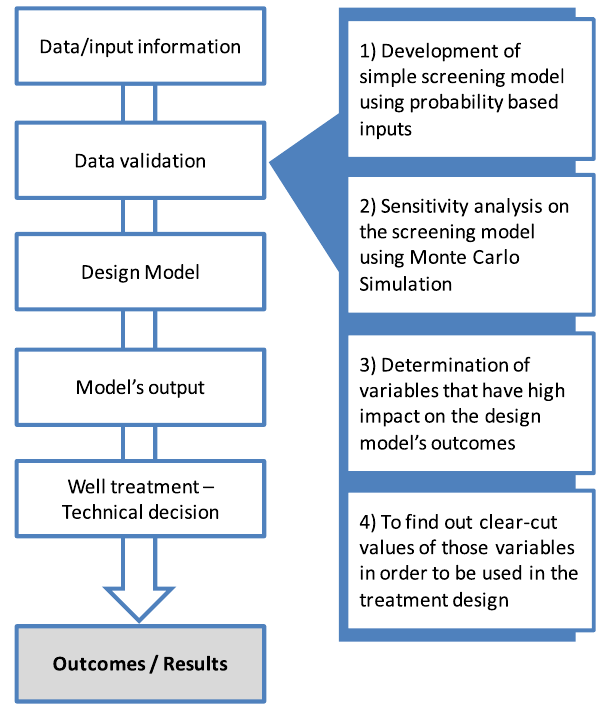
Fig. 1 Contribution of the probability-based modeling approach to the process flow of a well